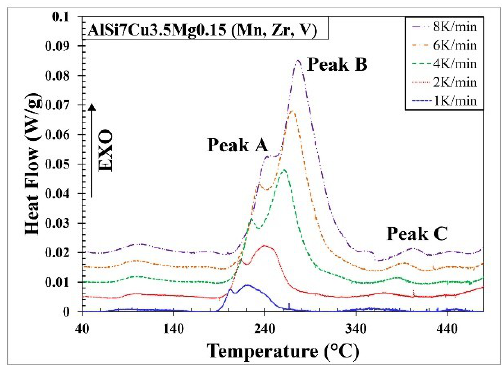
Figure 3. Differential scanning calorimetry (DSC) runs made with 1, 2, 4, 6, and 8 K/min heating rates Figure 3. Di ff erential scanning calorimetry (DSC) runs made with 1, 2, 4, 6, and 8 K / min heating rates for as-quenched AlSi7Cu3.5Mg0.15 (Mn, Zr, V) alloy. for as-quenched AlSi7Cu3.5Mg0.15 (Mn, Zr, V) alloy.